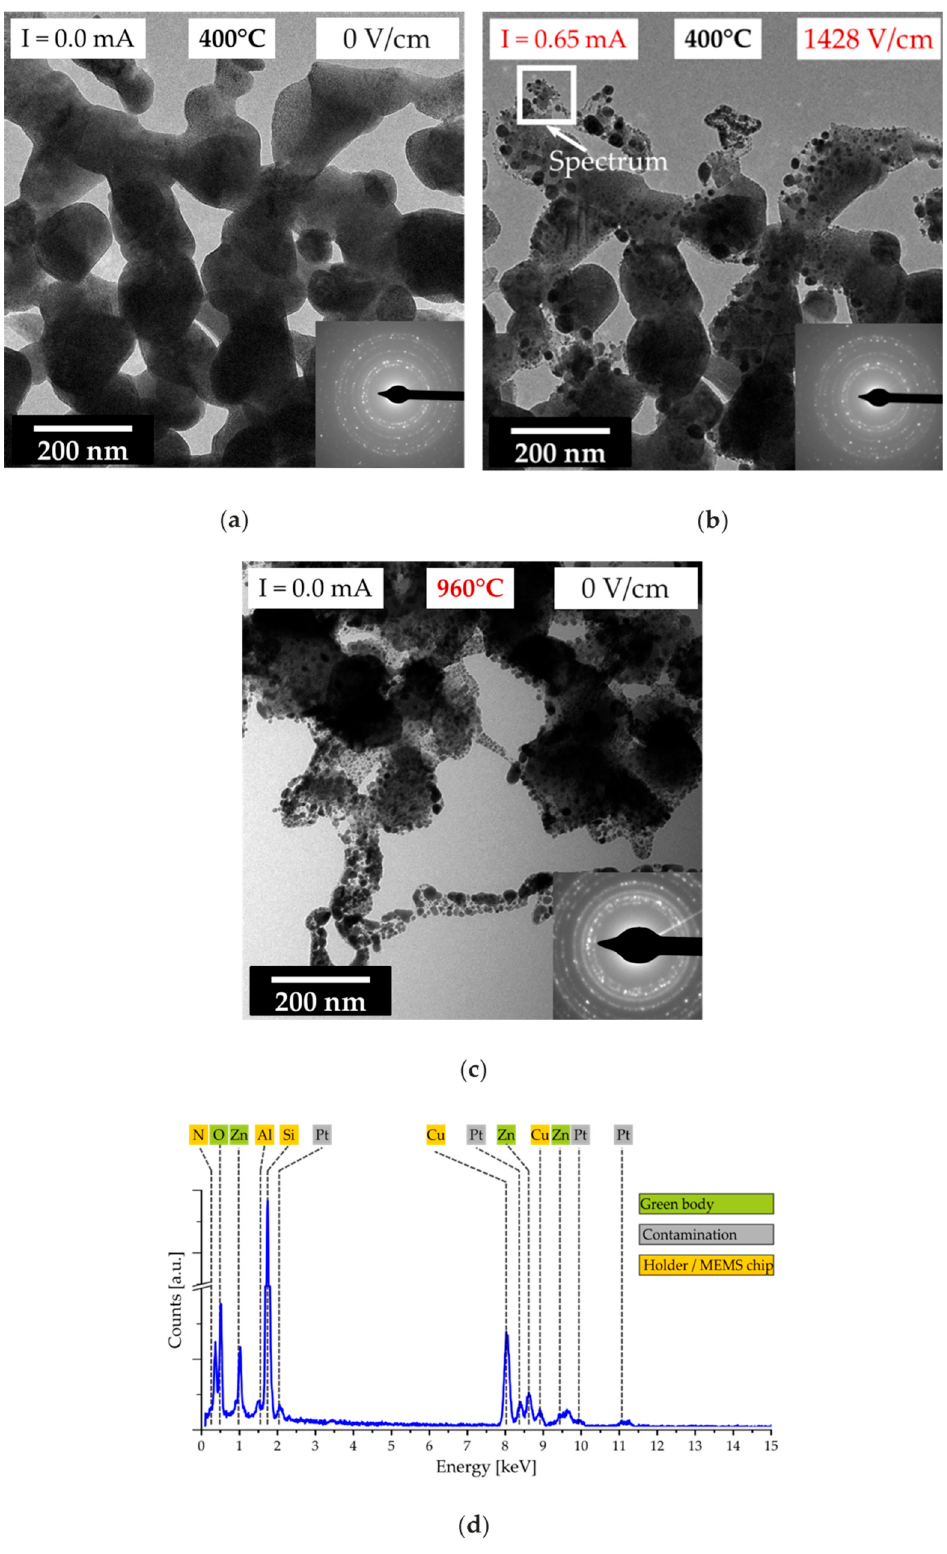
Figure 6. ZnO green body shrinkage in TEM. ( a ) The green body is stable at 400 °C, ( b ) but shrinks and forms precipitates under an applied field and current. ( c ) Similar behavior is observed upon heating above 800 °C without current. ( d ) EDX spectra of the marked region in ( b ), revealing Pt contamination of the sintered material.